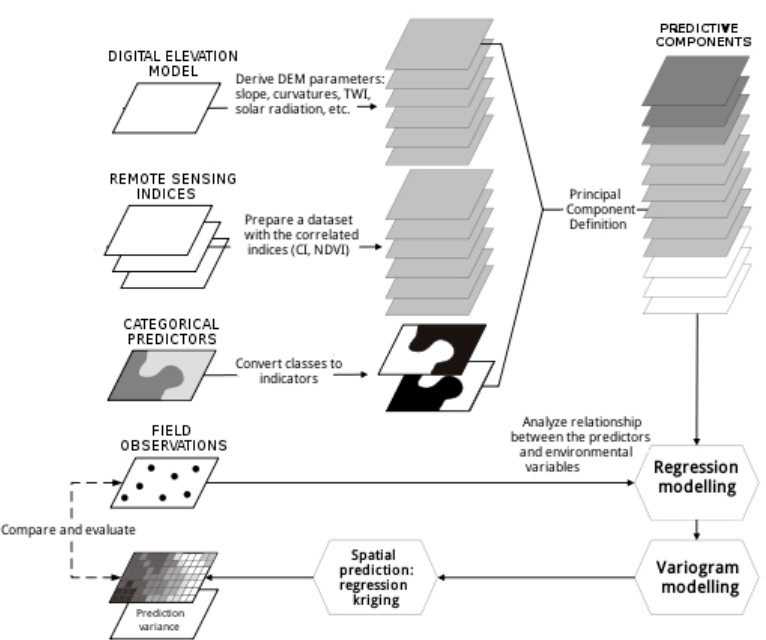
Figure 2. Flowchart showing the computational procedure for Digital Soil Mapping (DSM) based on Regression Kriging (RK) [47].